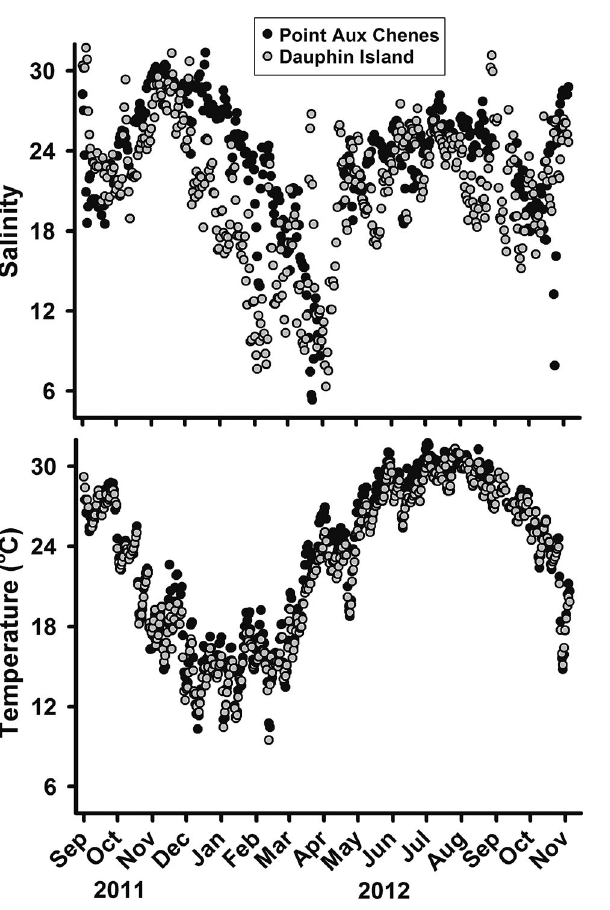
Fig. 2. Daily water temperature and salinity from September 2011 to November 2012 from continuous recorders at Fig. 3. Mean (±SD) interval water salinity and temperature Dauphin Island Sea Lab and Point Aux Chenes stations from September 11, 2011 to November 12, 2012 calculated (see Fig. 1) from daily salinity and temperature recorded at Dauphin Island Sea Lab and Point Aux Chenes stations. Groups that do not share letters have means that are significantly different (p <